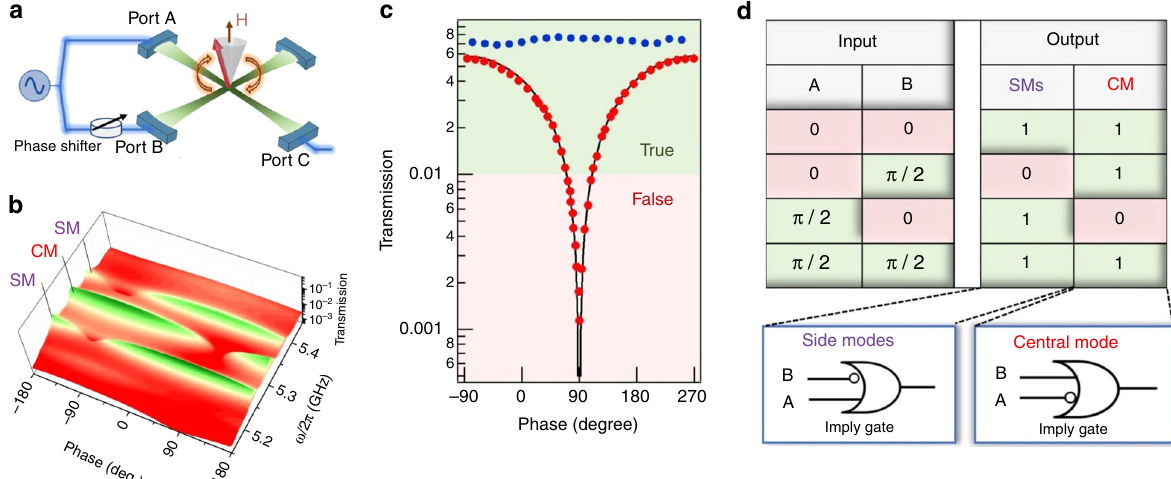
Fig. 5 Imply gate logic operations based on dynamic Hall-like transport. a Experimental setup using a low-loss mechanical phase shifter to introduce the phase difference Φ between ports A and B. b Transmission amplitude mapping measured at port C by continuously tuning the phase difference between the two inputs. The central mode (CM) amplitude shows a different phase dependence compared with the side modes (SMs). c Transmission amplitude of the central mode plotted as a function of the phase. Here, the blue solid symbols represent the result measured at 0 mT. d The logic table for the imply gates constructed using the response of the side modes (SMs) and central mode